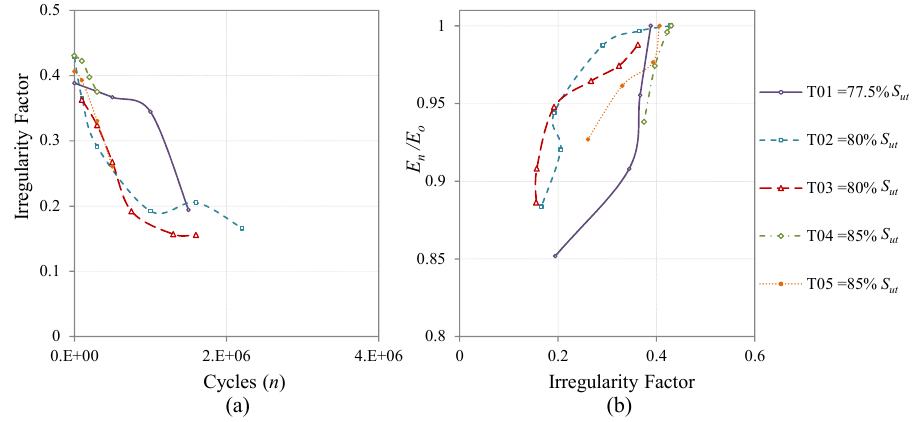
Figure 12. Evolution of the I ‐ Factor of all the coupons cycled with MiniTwist. The shown I ‐ Factor for each coupon is the mean value of all the areas of inspection; ( a ) Evolution through the fatigue cycles; ( b ) Relation between the evolution of the stiffness degradation and the evolution of the I ‐ Factor.